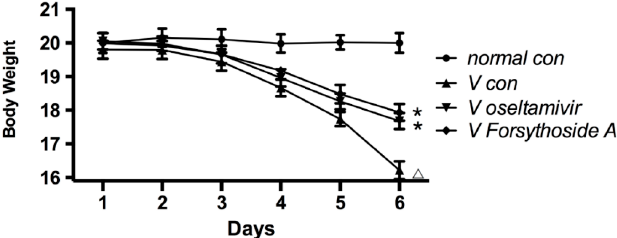
Figure 2. Changes in mice body weight. The body weight of mice in V con , V oseltamivir and V FTA began to decline on day 3. Body weight of Mice in V con decreased more quickly than V oseltamivir and V FTA . Δ p < 0.01 compared with normal con . * p < 0.01 compared with V con .